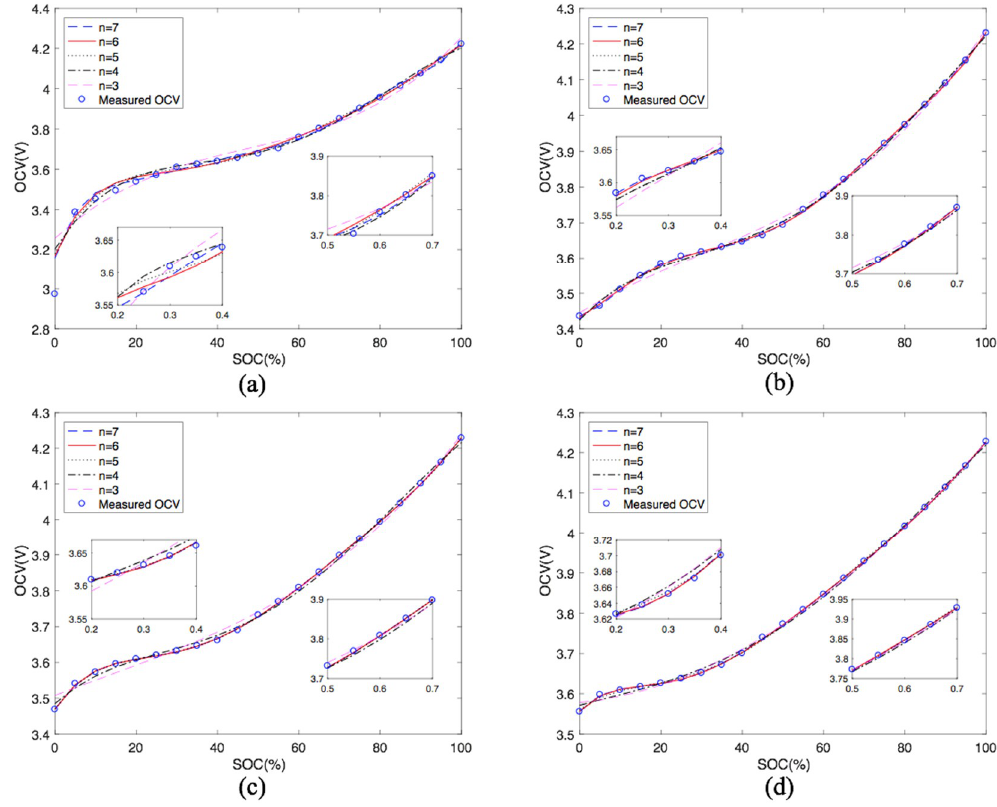
Figure 5. OCV‐SOC measured points and different orders polynomial fitting curves for; ( a ) 45 °C; ( b ) 25 °C; ( c ) 0 °C; and ( d ) −20 °C temperatures.